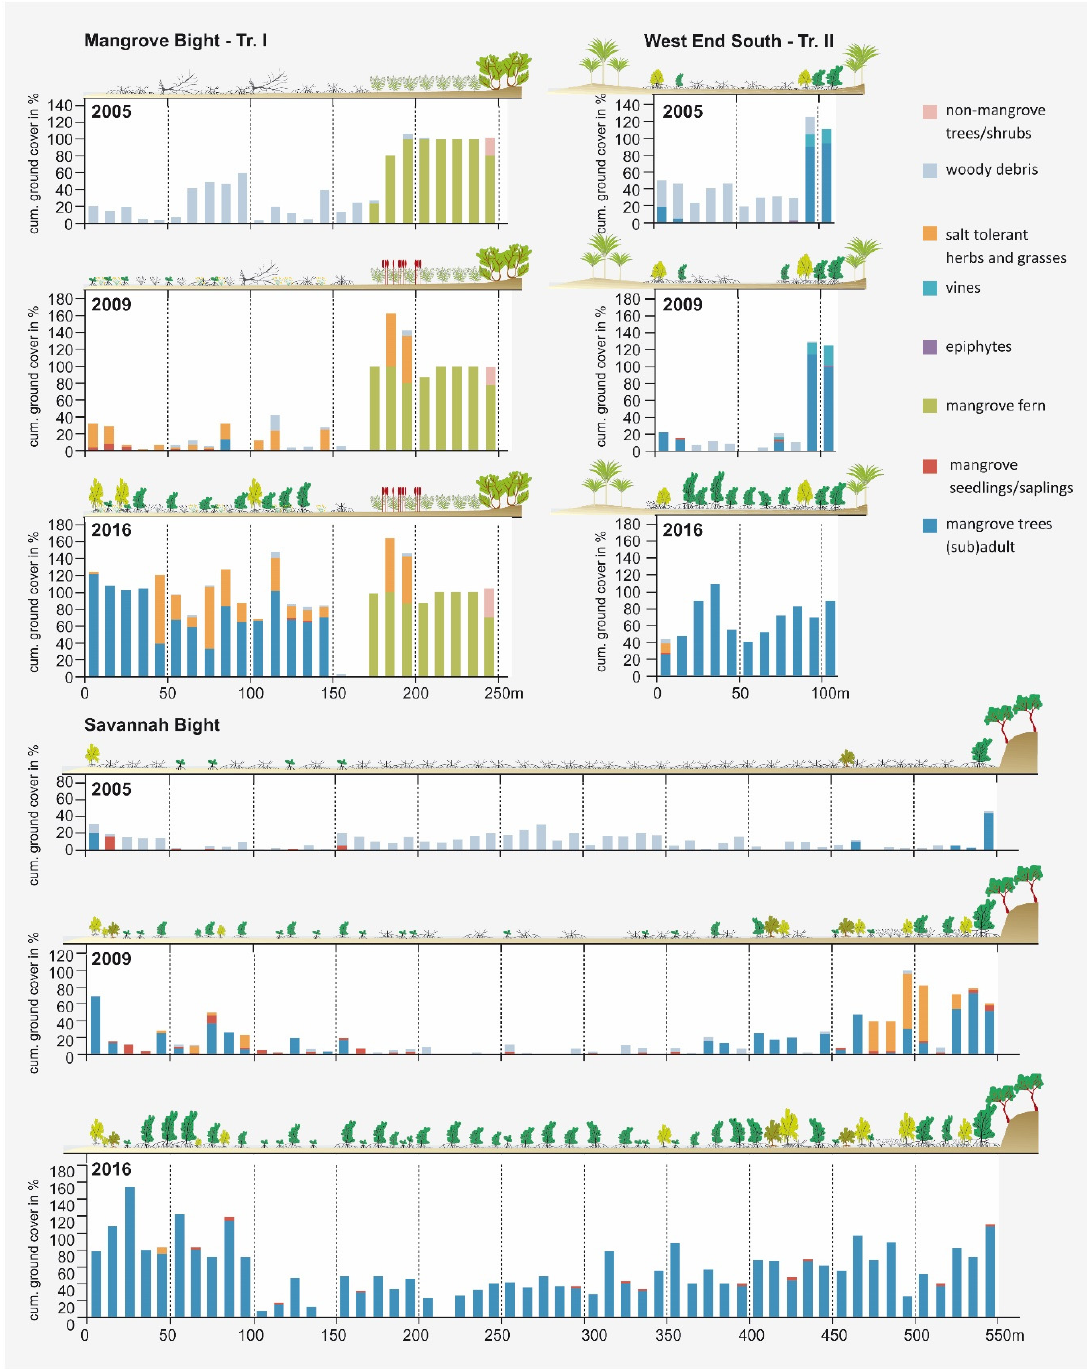
Figure 4. Vegetation development documented along the line transects at MB, SB, and WES for the three different sampling dates in 2005, 2009, and 2016. Due to space limitations, only one transect (of the two) is displayed for MB and WES.